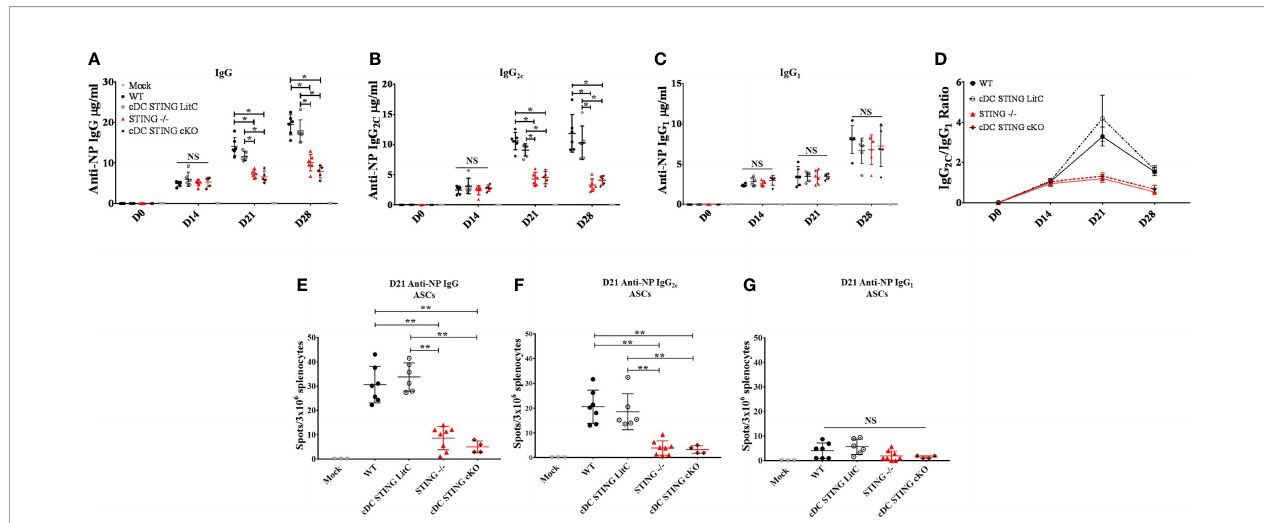
FIGURE 5 | STING is required within conventional dendritic cells for DNA vaccine induction of antigen-speci fi c IgG 2C antibody responses. WT, STING -/- , cDC STING cKO and cDC STING LitC mice IM/EP vaccinated with pNP. Sera were collected prior to vaccination (D0), 14 days (D14), 21 (D21) and 28 days post-vaccination (D28). Anti-NP (A) IgG, (B) IgG 2C and (C) IgG 1 antibody responses was measured by ELISA as described above. (D) The Th1:Th2 ratio was calculated as the ratio of IgG 2C :IgG 1 . A Th1:Th2 score >1 indicates a predominantly Th1 responses with a higher score indicating a strong Th1 response. Antibody secreting cells (ASCs) in WT, STING -/- , cDC STING cKO and cDC STING LitC mice vaccinated with pNP were measure 21 days post-vaccination by B cell ELIspot. Shown are (E) IgG, (F) IgG 2C and (G) IgG 1 ASCs. Three independent experiments were performed consisting of 3-7 mice; representative data shown are the average± SD of 3-7 mice/ genotype. A one-way ANOVA was employed to compare groups, *p < 0.05, **p < 0.01 and NS, not signi fi cant.